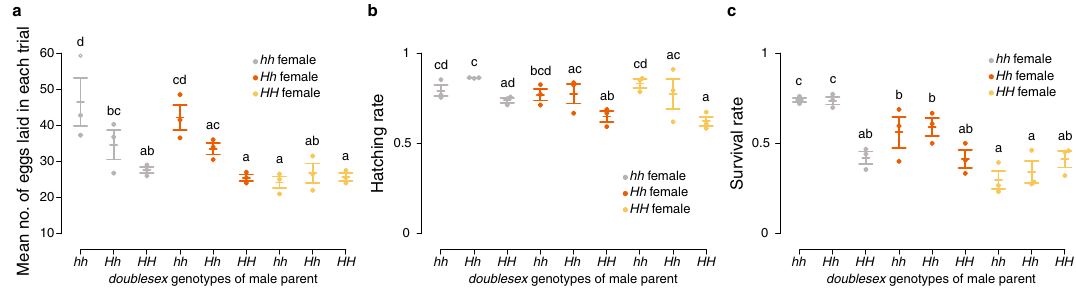
Figure 2. Mean number of eggs laid in each trial ( a ), hatching rate ( b ), and larval survival rate ( c ) in each doublesex genotype of parents. We used crosses between all combinations of dsx genotypes. Parental females were captured in the wild, and the offspring were used for crossing. Grey plots, hh female parents; orange plots, Hh female parents; yellow plots, HH female parents. Middle bar represents mean, and upper and lower bars indicate standard error. Different letters indicate significant differences between groups (Tukey post hoc test, P < 0.05; Supplementary Table S5). ( a ) Y-axis shows the mean number of eggs laid in each egg correction trial, and plots show the mean number of eggs laid by each H allele may have reduced fecundity through nutritional investment in spermatophore, which affects the repro- ductive output of females 35 . A total of 1767 eggs hatched, and the overall hatching rate was 77.3%. Variations in hatching rate could also be explained by the genotypes of female and male parents and their interactions (Fig. 2b, Supplementary Tables S1, S2). The hatching rate of eggs laid by hh females crossed with Hh males was higher than that of eggs laid by hh , Hh , and HH females crossed with HH males (Fig. 2b; Tukey post hoc test, P < 0.01; Table S5). Meanwhile, the hatching rate of eggs laid by hh females crossed with hh males was higher than that of eggs laid by Hh and HH females crossed with HH males (Tukey post hoc test, P < 0.05; Table S5). The hatch- ing rate of eggs laid by HH females crossed with HH males was significantly lower than that of eggs laid by hh , Hh , and HH females crossed with hh males (Tukey post hoc test, P < 0.01; Table S5). Finally, we obtained 1,017 pupae and calculated larval survival rate. The overall survival rate was 57.6%. Variations in larval survival rates could be explained by the genotypes of female and male parents and their interactions (Fig. 2c, Supplementary Tables S1, S2). Survival rates of larvae of hh females crossed with hh and Hh males were significantly higher than those of larvae of other females (Fig. 2c; Tukey post hoc test, P < 0.05; Table S5). Meanwhile, survival rates of larvae of HH females crossed with hh and Hh males were significantly lower than those of larvae of hh and Hh females crossed with hh and Hh males (Fig. 2c; Tukey post hoc test, P < 0.05; Table S5). Although we explored the effects of parental genotypes in this study, offspring genotypes may be more important for larval survival rate than parental genotypes. However, our experiments could not distinguish between the effects of parental and offspring genotypes. For instance, larvae of hh females crossed with hh males showed significantly higher survival rate than larvae of HH females crossed with HH males (Tukey post hoc test, P < 0.001; Table S5). This difference can be explained by both parental and offspring genotypes. Meanwhile, when we compared the larvae of hh females crossed with Hh males to those of Hh females crossed with hh males, the segregation of dsx geno- types was identical ( hh : Hh = 1:1) but the survival rate was significantly different (Tukey post hoc test, P < 0.001; Supplementary Table S5), suggesting a pivotal role of parental genotypes in offspring survival. Finally, using a cross between females and males heterozygous for dsx (i.e. Hh ), we compared the mortal- ity, larval developmental duration, pupal period, adult forewing length, and adult lifespan amongst the three genotypes, namely HH , Hh , and hh (expected HH : Hh : hh ratio = 1:2:1), and between the two sexes (expected male:female ratio = 1:1). Larvae were reared on an artificial diet containing Insecta F-II (Nihonnosankogyo, Japan) and Citrus natsudaidai leaf powder under long-day conditions (light:dark = 16:8 h) at 25 °C. The mortality rate during the larval period was 39.6% (Table 1). The genotypic frequencies of dead and eclosed individuals were consistent with the expected 1:2:1 ratio (Table 1). The sex ratio of eclosed individuals was consistent with the expected 1:1 ratio, but more males than females eclosed as healthy individuals, excluding individuals with eclo- sion insufficiency, such as abnormal wings (68.6% males) (Table 1). Genotype and sex did not affect larval devel- opmental duration, pupal period, and adult forewing length (Supplementary Fig. S2, Supplementary Tables S3, S4). Finally, we compared the adult lifespan amongst genotypes and sexes in healthy individuals and individuals with slight eclosion insufficiency (flight is possible, but the wings are not fully extended) (Table 1). We also used additional individuals from the laboratory populations (females, hh : Hh = 5:4; males, hh : Hh = 1:2) to increase the number of samples analysed. A total of 61 individuals (females, hh : Hh : HH = 8:13:6; males, hh : Hh : HH = 8:16:10) were used to measure adult lifespan. Differences in parental genotypes were included in the statistical model as a random effect. Parental genotypes, sexes, and their interaction explained differences in adult lifespan (Sup- plementary Tables S3, S4). Notably, adult lifespan of HH females was significantly shorter than that of hh females (Fig. 3; Tukey post hoc test, P = 0.003; Supplementary Table S6), but there was no difference in adult lifespan of males amongst the genotypes (Fig. 3, Supplementary Table S6). Adult lifespan of hh females was much longer than that of males, although this difference was not significant (Fig. 3, Supplementary Table S6). Of note, we estimated the adult lifespan using unmated females and males. However, almost all females are usually mated in the wild (e.g. in Papilio memnon 36 ), then the longevity of mated females may also be explored for elucidating the effects of dsx-H on the adult lifespan. The effects of genotypes on adult lifespan were evident in females but not in males, which may be caused by differences in the expression patterns of dsx between sexes. However, the